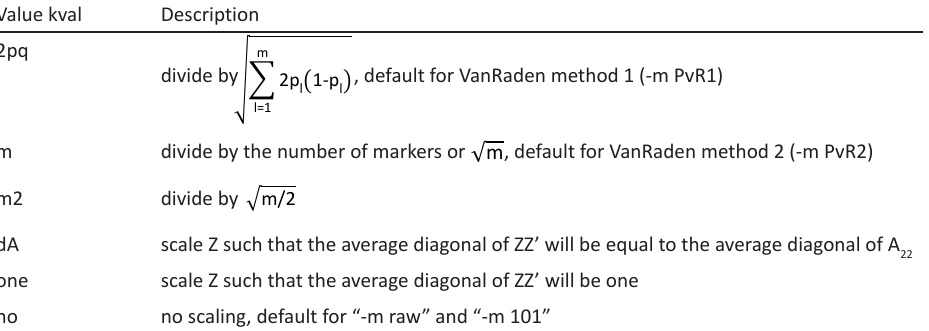
Table 3. Choices for the scaling of marker columns by option -c kval in the Z matrix Value